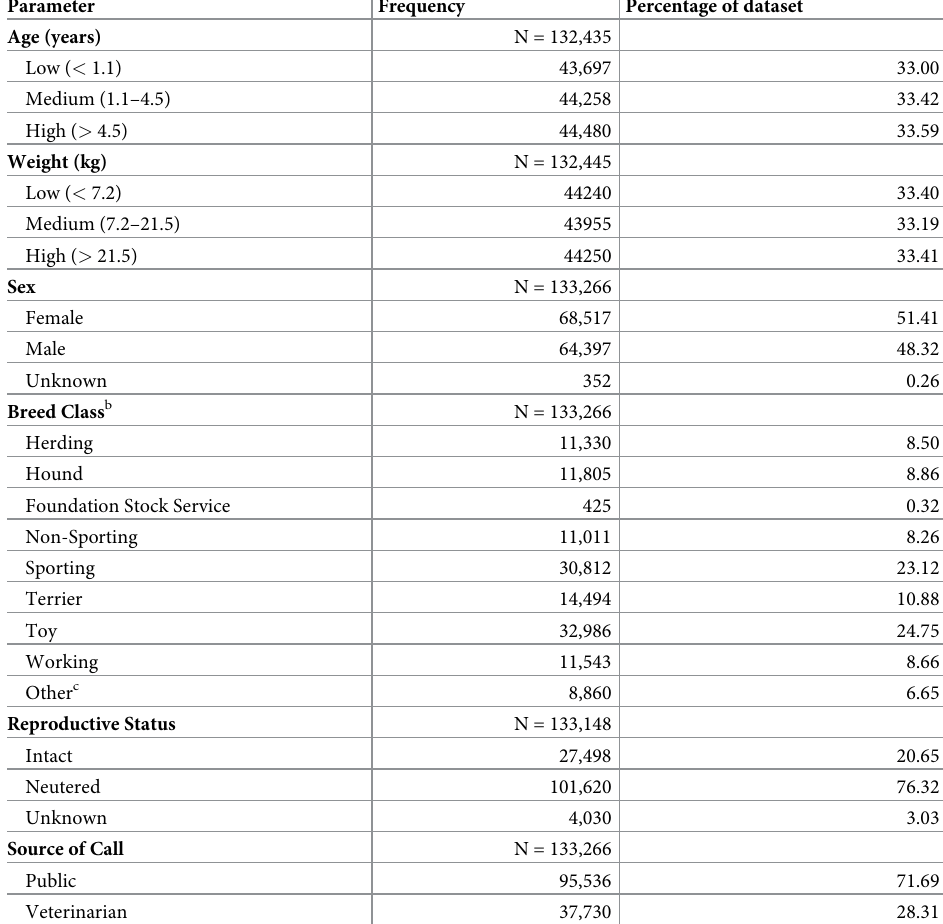
Table 2. The characteristics of calls made on behalf of dogs from the US reporting poisoning events to the APCC a (2009–2014).